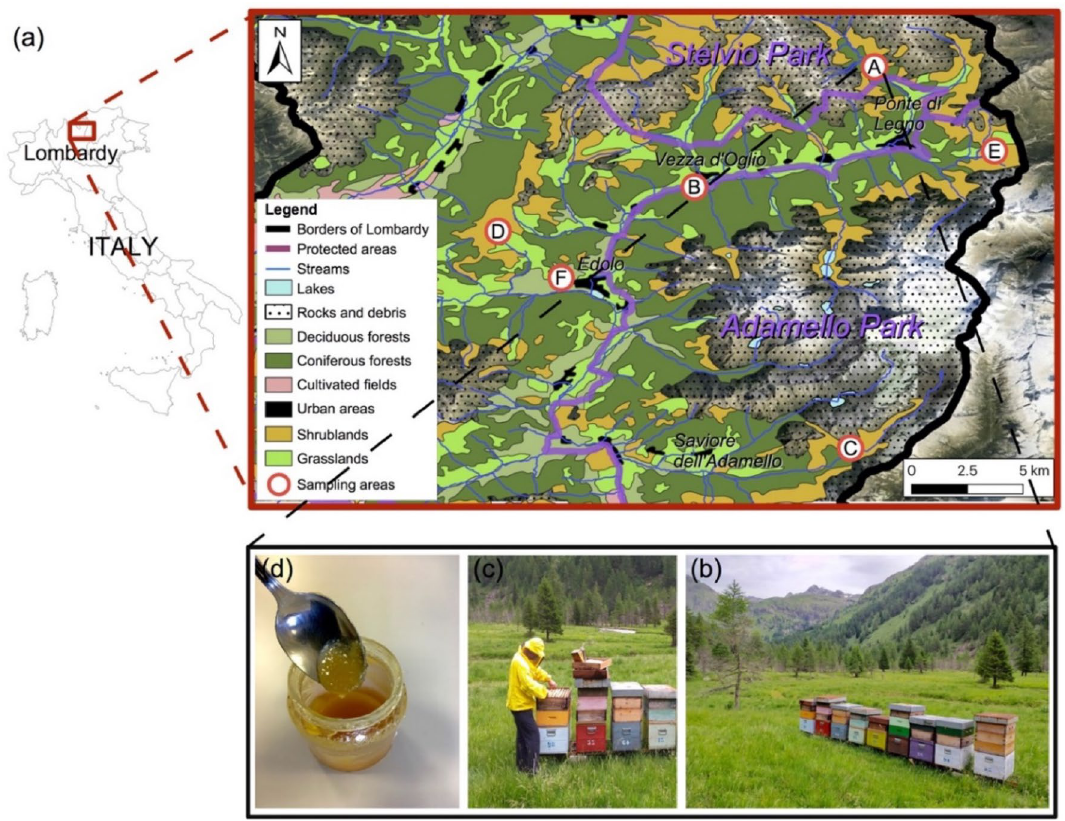
Figure 1. Map of the upper Camonica Valley with the six areas (A, B, C, D, E and F) where honey was produced and sampled ( a ) and location of the apiaries ( b ), collection of honey ( c ) and honey ( d ) produced in area A. The map was generated using ArcGIS Desktop 10.5 (Esri, Redlands, CA, USA, https:// www. esrii talia. it/ prodo tti/ la- nostra- offer ta/ piatt aforma- esri/ arcgis- 10-5).